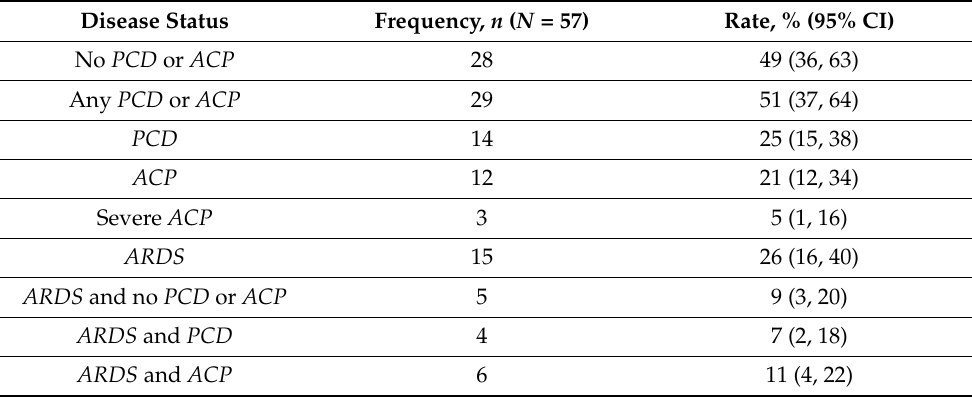
Table 2. Summary of PCD and ARDS incidence